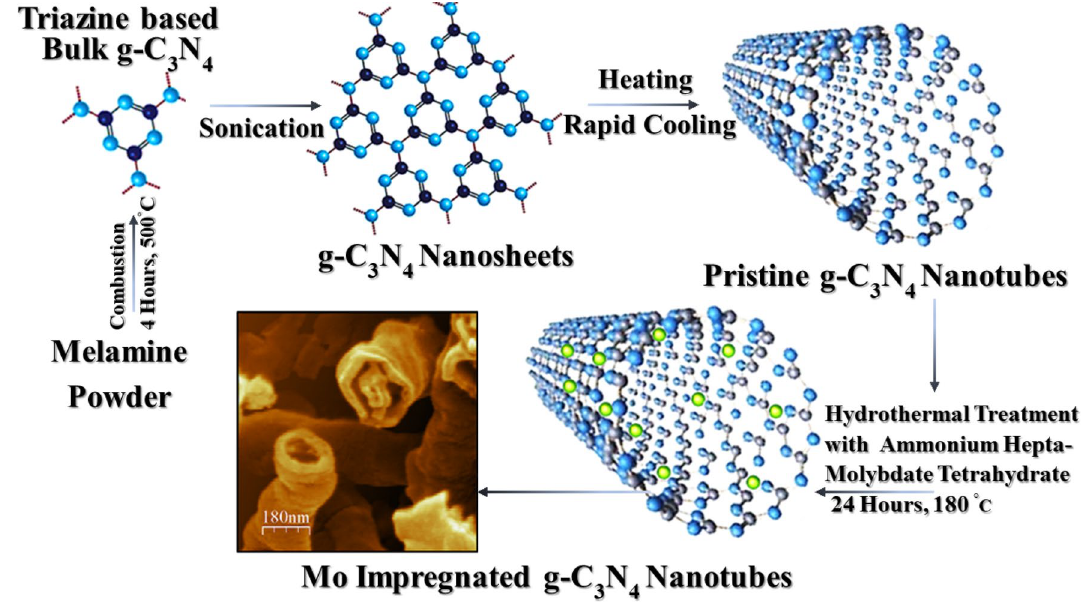
Figure 1. Schematic synthesis of Molybdenum impregnated graphitic carbon nitride nanotubes: Pristine